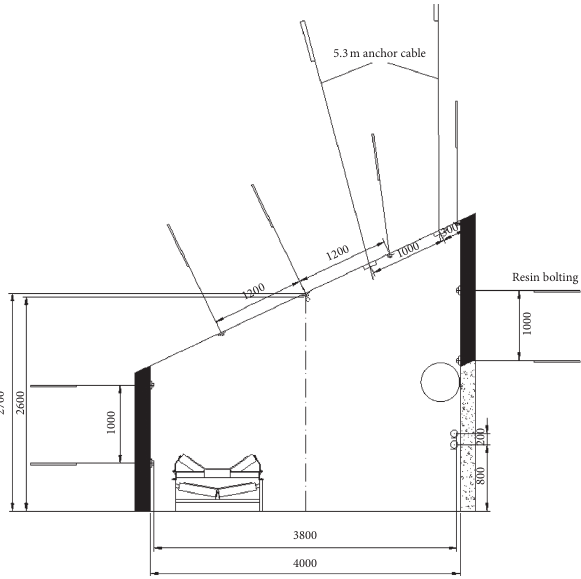
Figure 1: Support